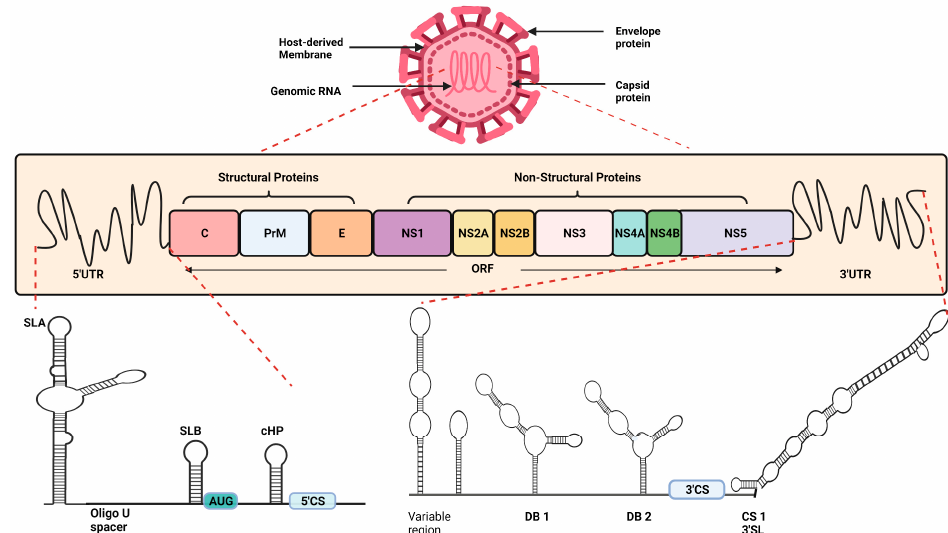
Figure 1. Structural organization of Dengue virus genome: The viral genome consists of 5 (cid:48) UTR, an ORF, and 3 (cid:48) UTR. The ORF encoding polyprotein serves as a template for the translation of 3 structural proteins (C (Capsid), PrM (Pre-Membrane), and E (Envelope)) and 7 Non-structural proteins (NS1, NS2A, NS2B, NS3, NS4A, NS4B, NS5). The representation of 5 (cid:48) UTR depicts Stem-loop structures (SLA and SLB) flanked by oligo U, wherein SLB is followed by initiator AUG and the hairpin structure (cHP) in the C encoding region. The following complementary sequence at 5 (cid:48) UTR is essential for genome circularization, which in turn is important for genome replication. The 3 (cid:48) UTR consists of variable sequences, followed by dumbbell structures DB1 and DB2. The approaching conserved sequence CS1 and stem loop (SL) at 3 (cid:48) UTR play a pivotal role in genome conformational changes facilitating